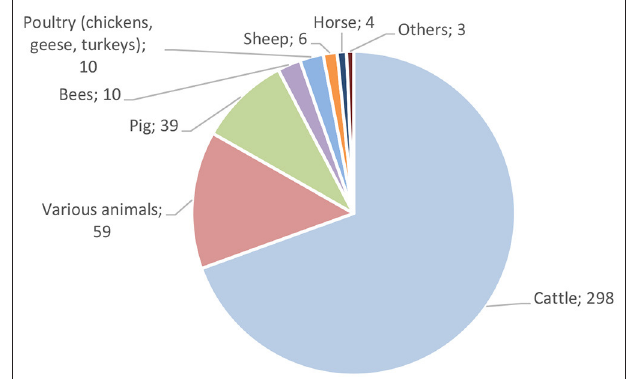
FIGURE 3 | Distribution of ethnoveterinary use reports by animal